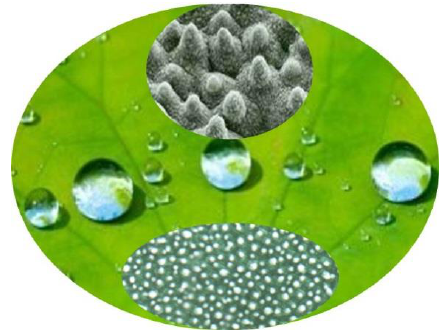
Figure 4. Superhydrophobic lotus leaf surface.